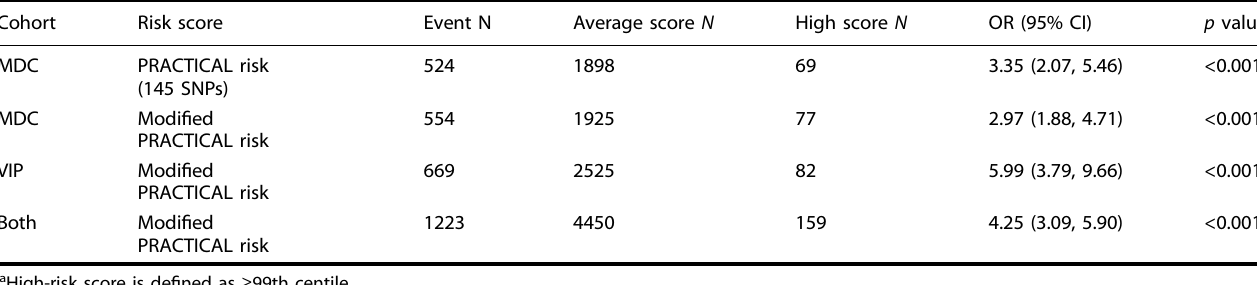
Table 3. Association between high-risk score a vs average risk score b and the outcome of incident diagnosis of any grade prostate cancer.